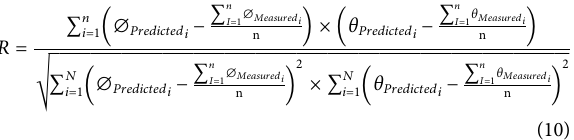
Figure 4 shows the heat map diagram for input and output variables to determine and predict PP based on Spearman ’ s correlation. As the information in this fi gure shows, the pairs of variables RHOB-PEF, CGR-SGR, RHOB-CALL, DT-PEF, PP- RHOB, Vs-RHOB, ILD-LLS, DT-CGR, and DT-NPHI are dependent on each other. The results depicted in this fi gure show the relationship between the variables, which determines the closeness and relationship between the parameters.